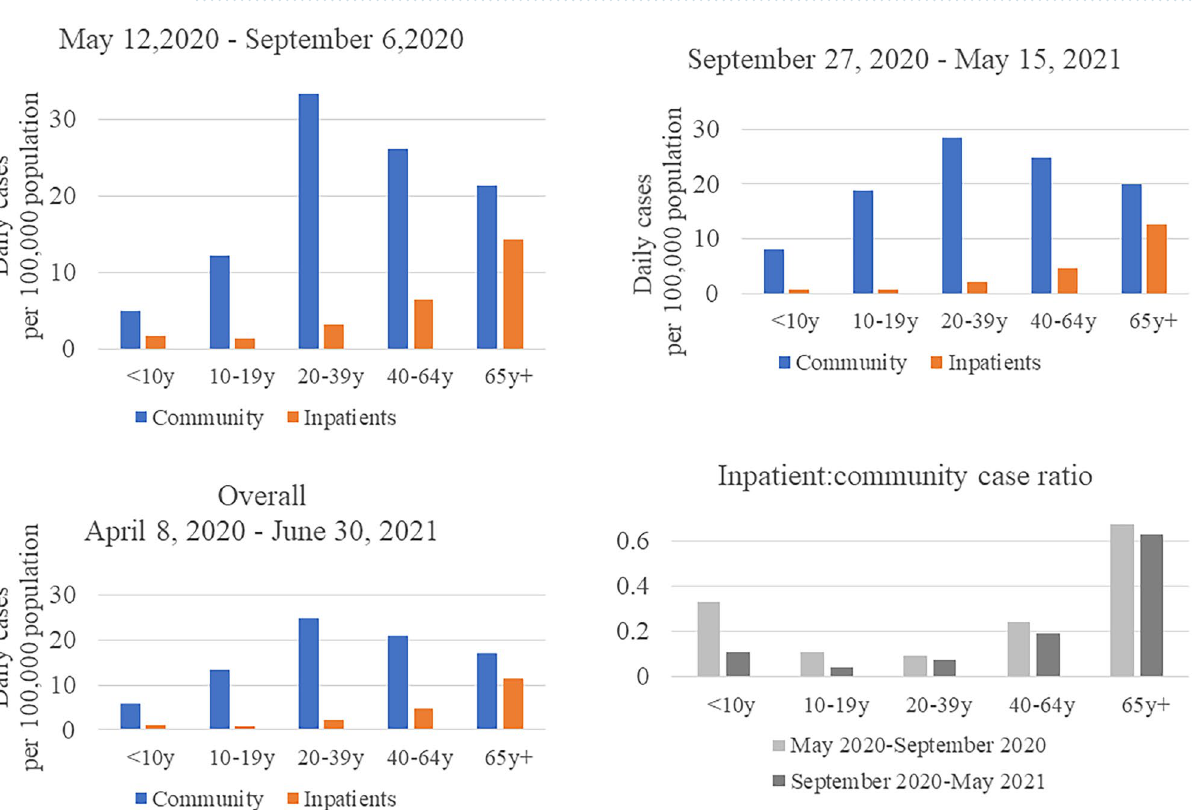
Figure 4. Daily growth rate in SARS-CoV-2 cases per 100,000 population among community residents a and inpatients b during outbreak waves in Harris County, stratified by age group. ( A ) May 2020 – September